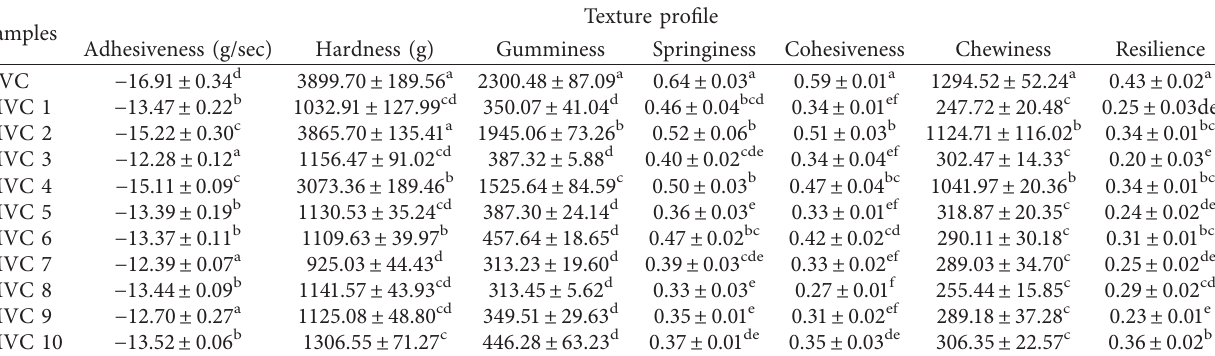
Table 3: Texture profile of village chicken meat obtained from a genuine supplier and 10 different markets.